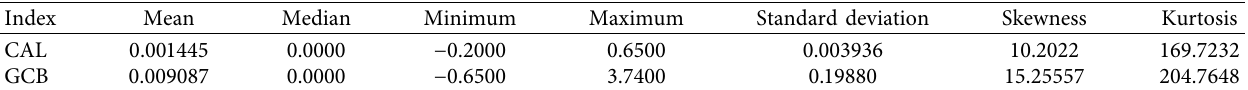
Table 3: Descriptive statistics of the returns series for CAL bank and GCB